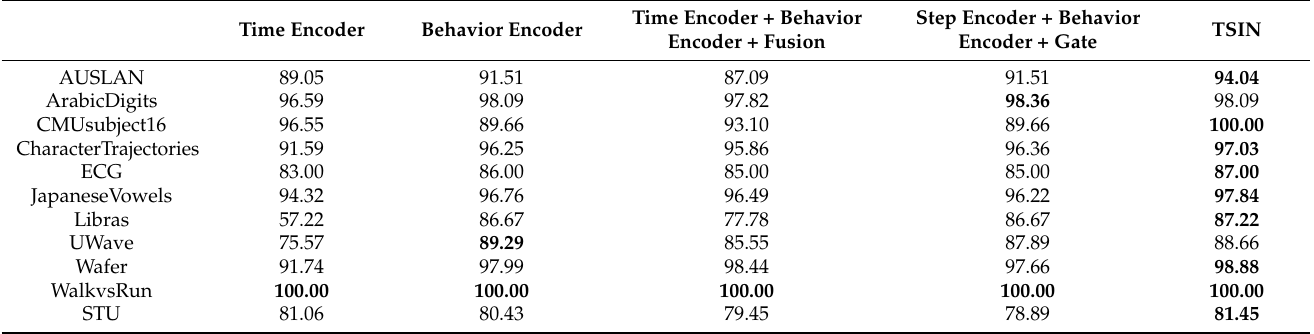
Table 3. Ablation study of the Time Encoder, Behavior Encoder, Intermediate Fusion Module and gating in the TSIN.